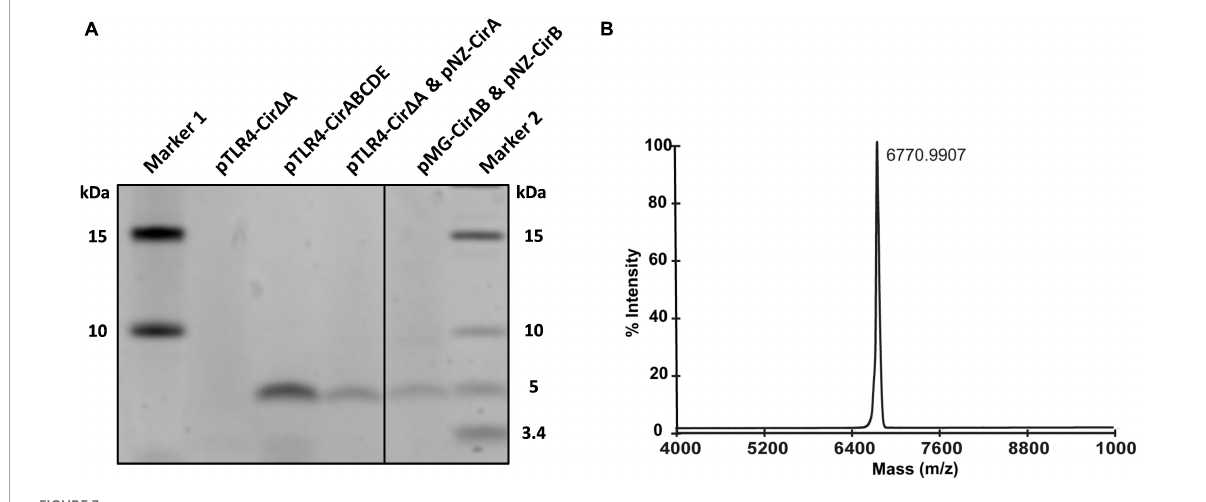
FIGURE3 Production comparison and MS confirmation of circularin A. (A) Tricine-SDS-PAGE protein gel for antimicrobial production comparation in three expression constructs. (B) Matrix-assisted laser desorption/ionization-time of flight (MALDI-TOF) spectrum for molecular mass detection to confirm the production and modification of circularin A (theoretical mass: 6771.05